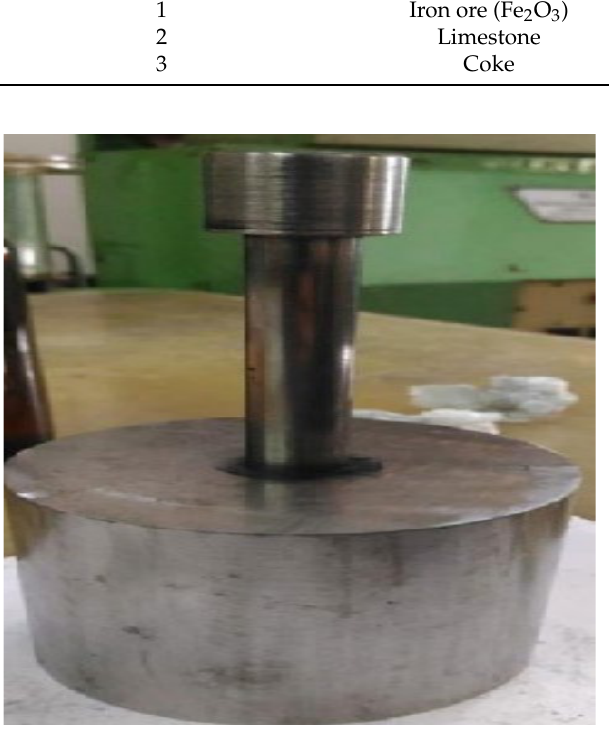
Figure 4. Compacting die.